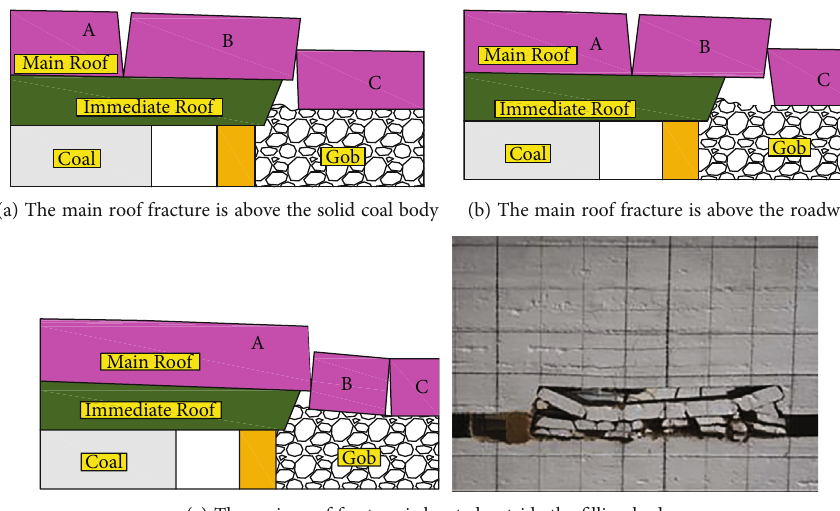
Figure 3: Main top lateral fracture structure.